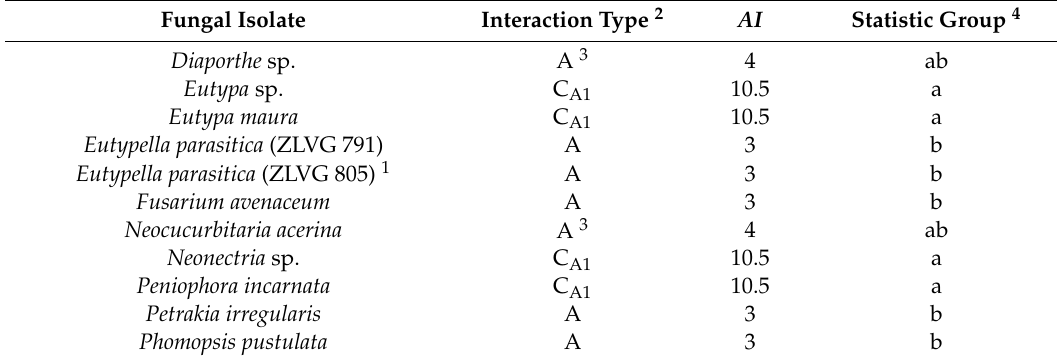
Table 3. Interaction type and antagonism index ( AI ) of E. parasitica in dual culture assays. Fungal